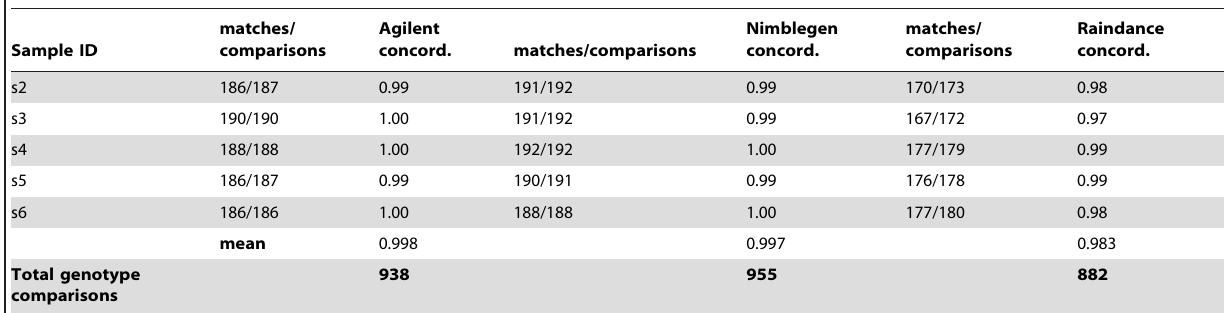
Table 5. Genotype concordance.